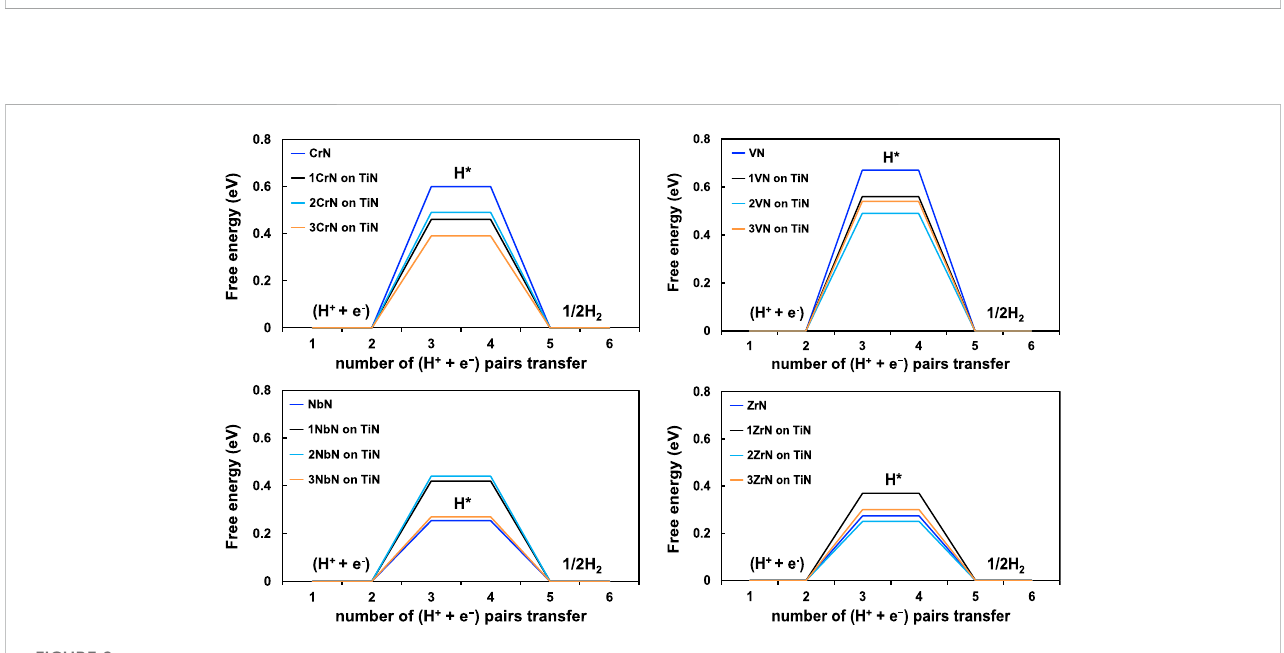
Schematic representation of the modelled system for one, two, and three monolayers of CrN on TiN, from left to right respectively, tilted side view. Blue represents nitrogen, grey chromium, and bronze titanium. The unit cell is repeated in the x and y